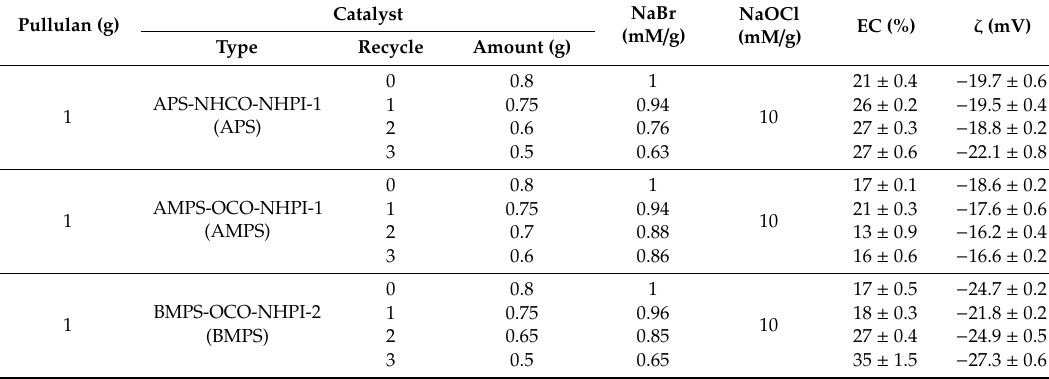
Table 2. Electrokinetic charge (EC) and zeta potential ( ζ ) for pullulan samples oxidized in the presence of the NHPI-supported